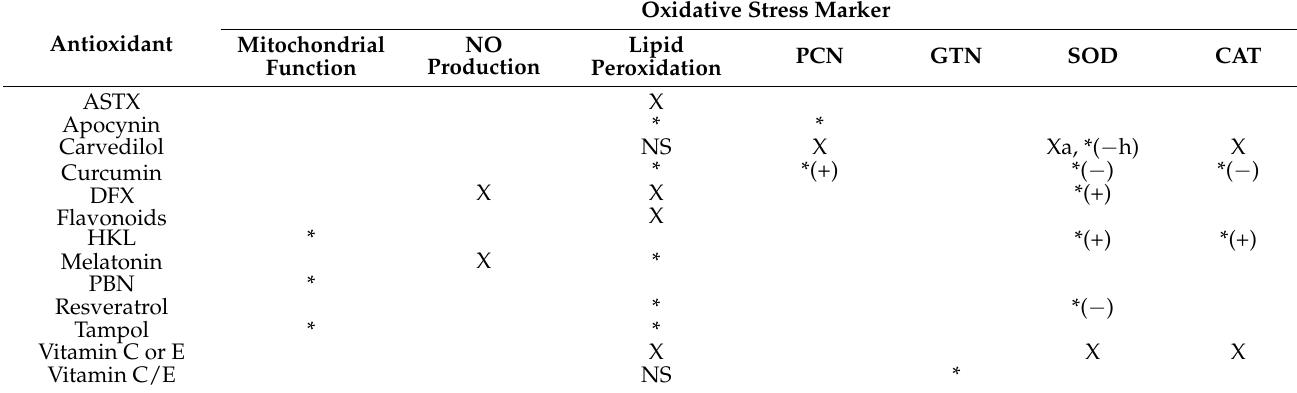
Table 1. Oxidative markers and antioxidants evaluated in T. cruzi infection and Chagas disease.